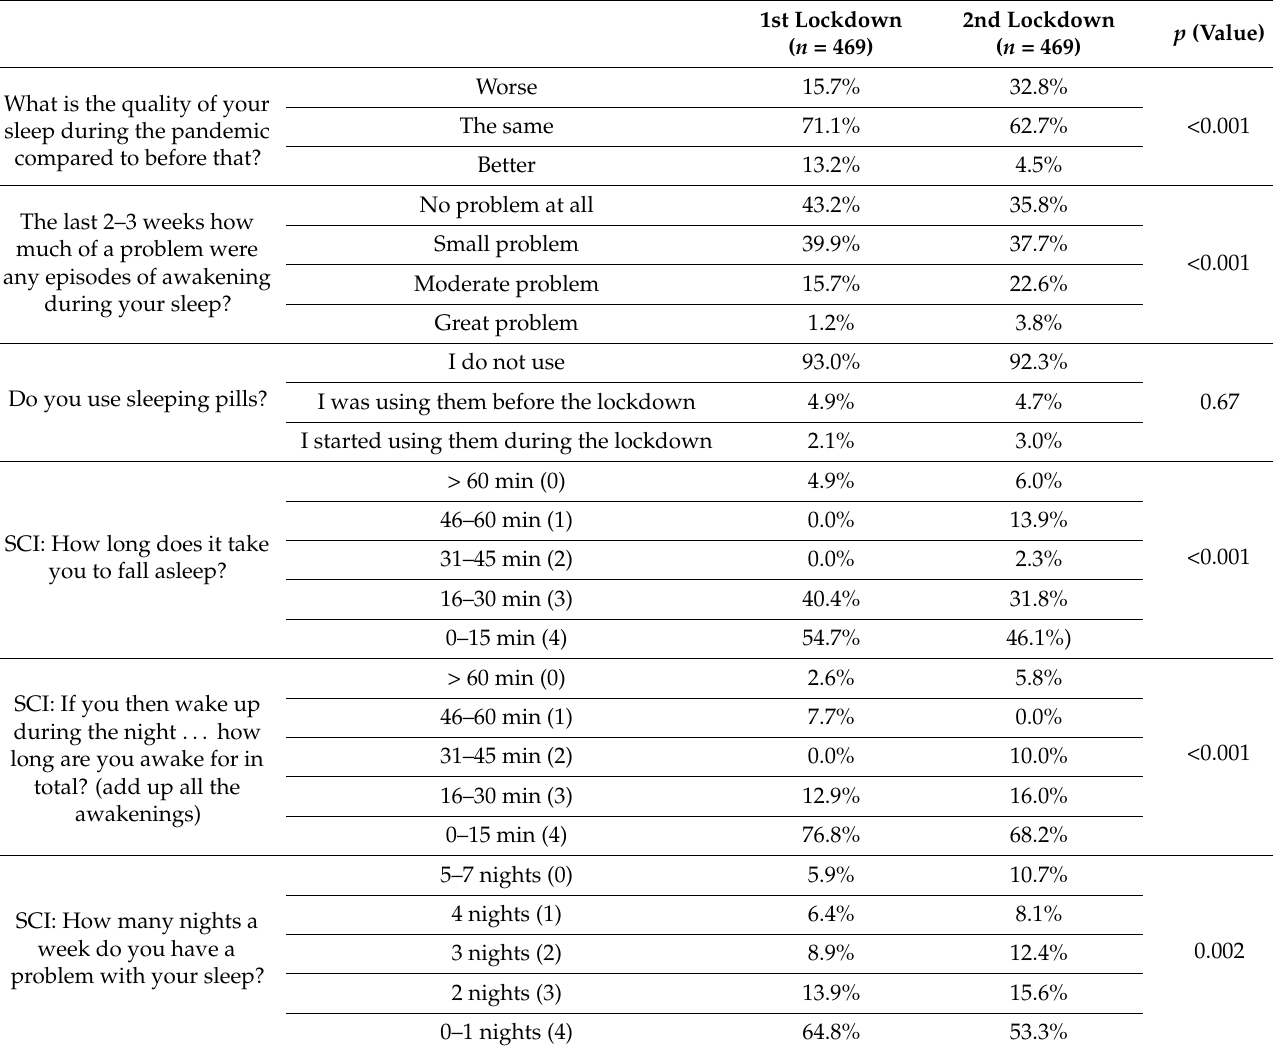
Table 3. Comparison of sleep-related variables of participants followed up during the 1st and 2nd